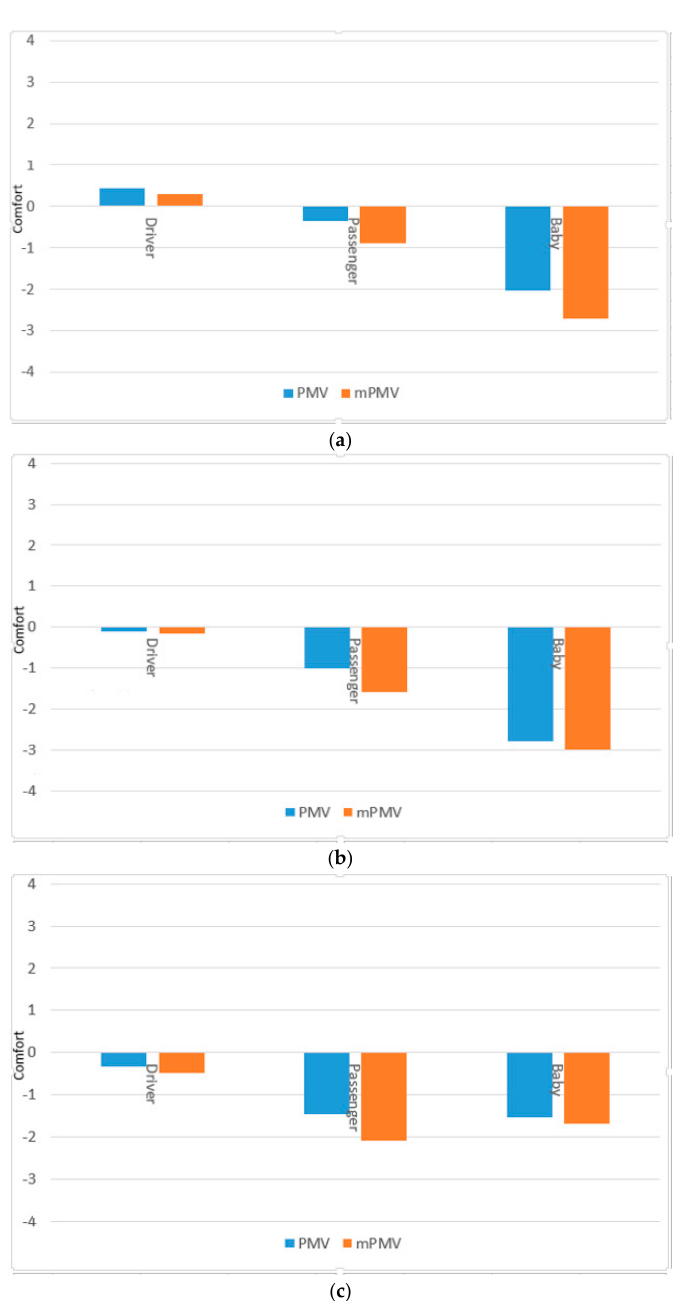
Figure 6. Predicted thermal comfort for the three considered ventilation cases after 30 min of